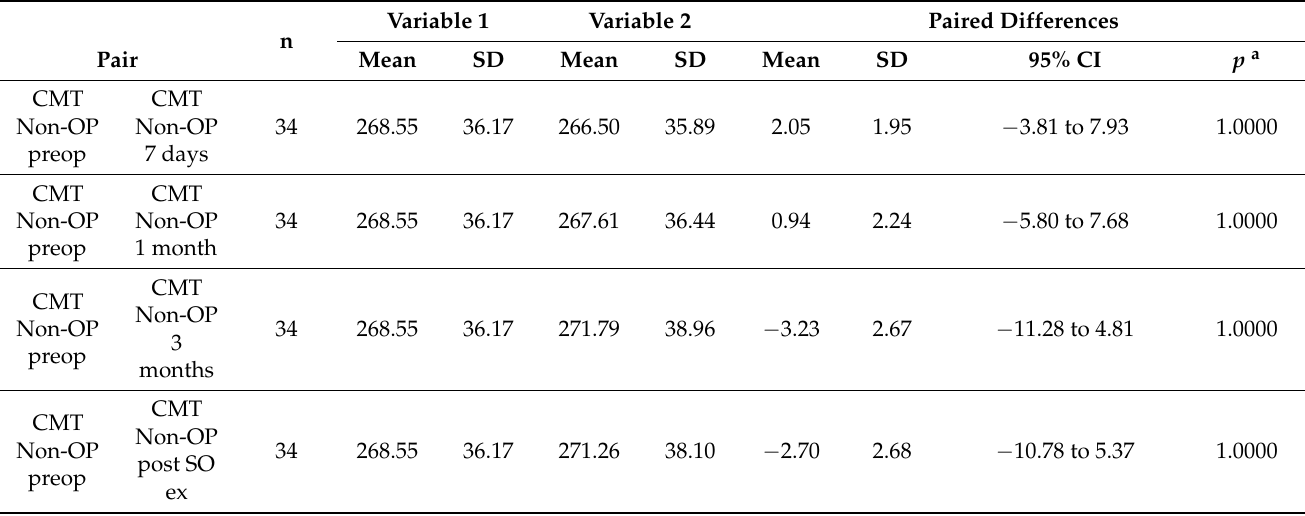
Table 3. Central macular thickness—CMT ( µ m) in non-operated eyes.